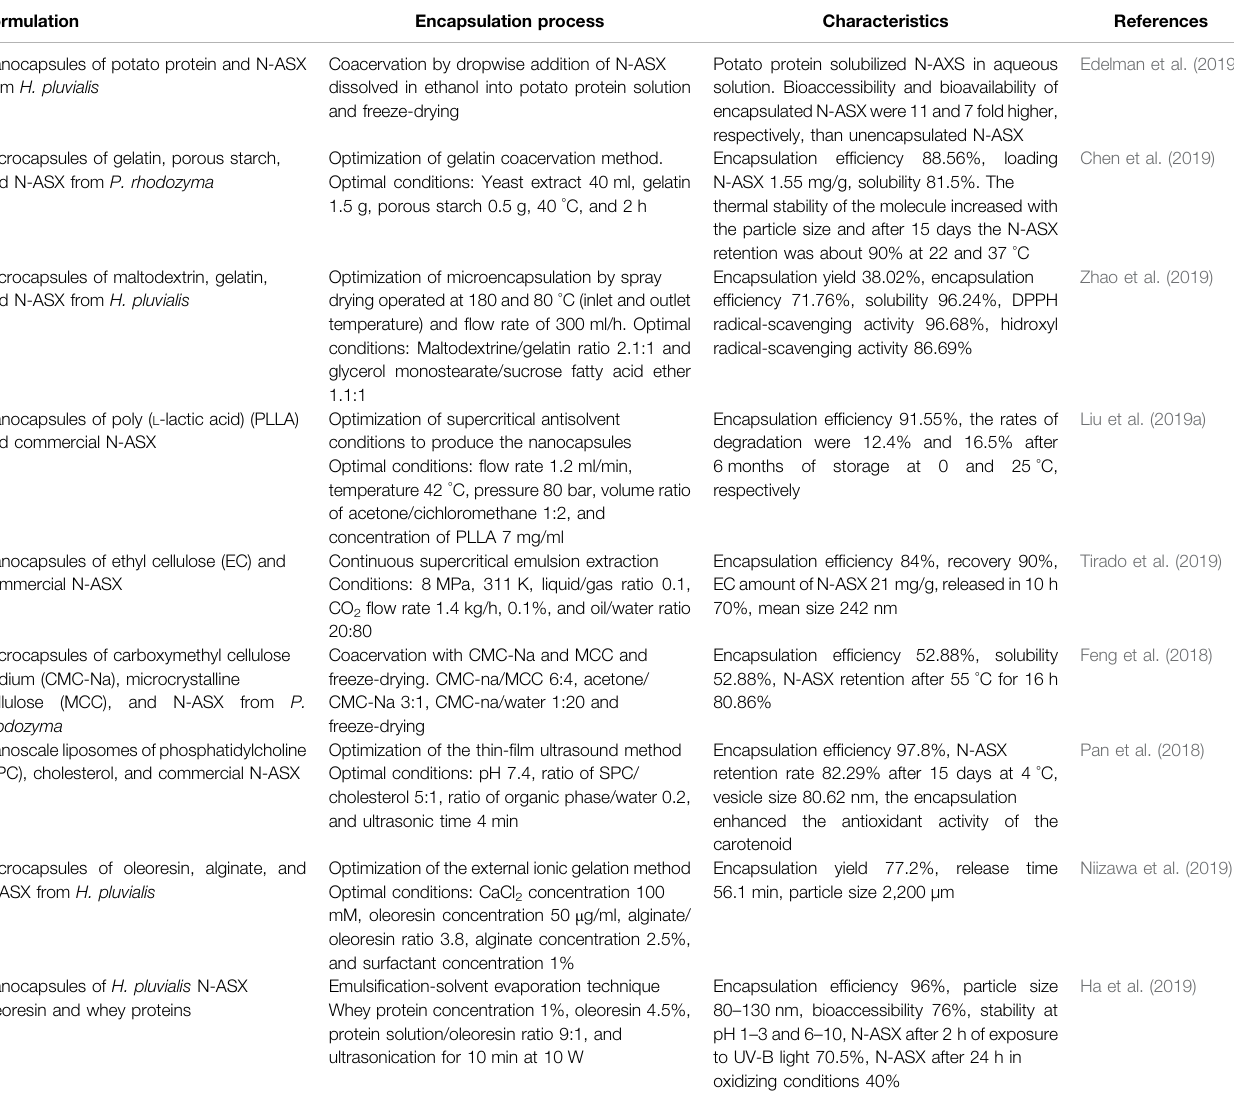
TABLE 6 | N-ASX formulations obtained by different encapsulation